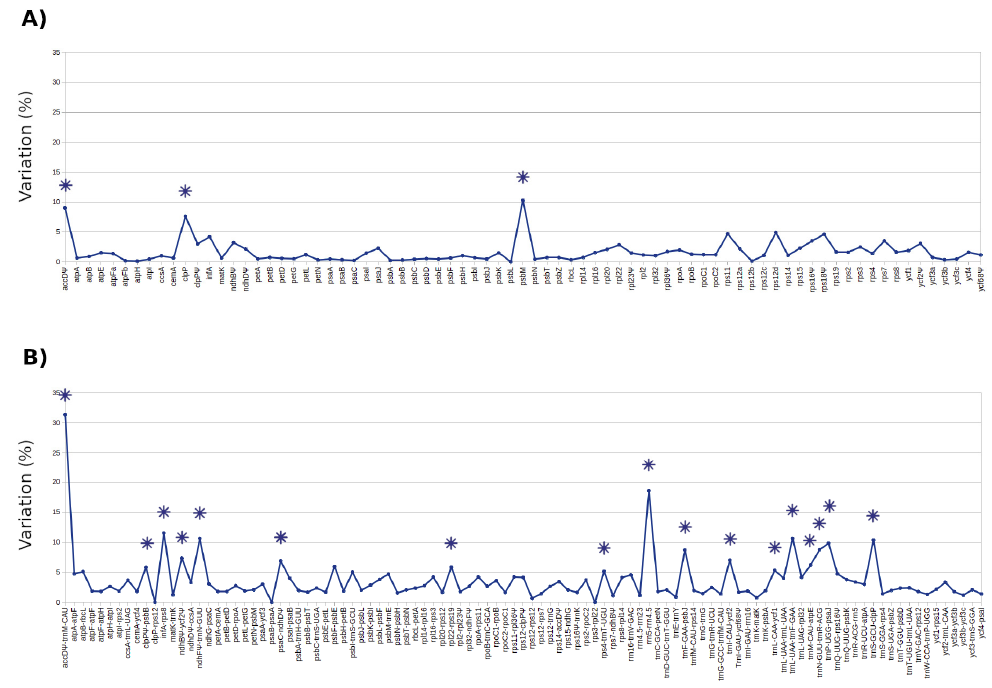
Figure 4. Distribution of the percentage of molecular variation across 180 homologous loci. Average percentage variation of the ( A ) coding and ( B ) non-coding homologous loci in the seven chloroplast genomes of Mammillaria. The 20 loci with the highest molecular variation are indicated with asterisks (*). ✴